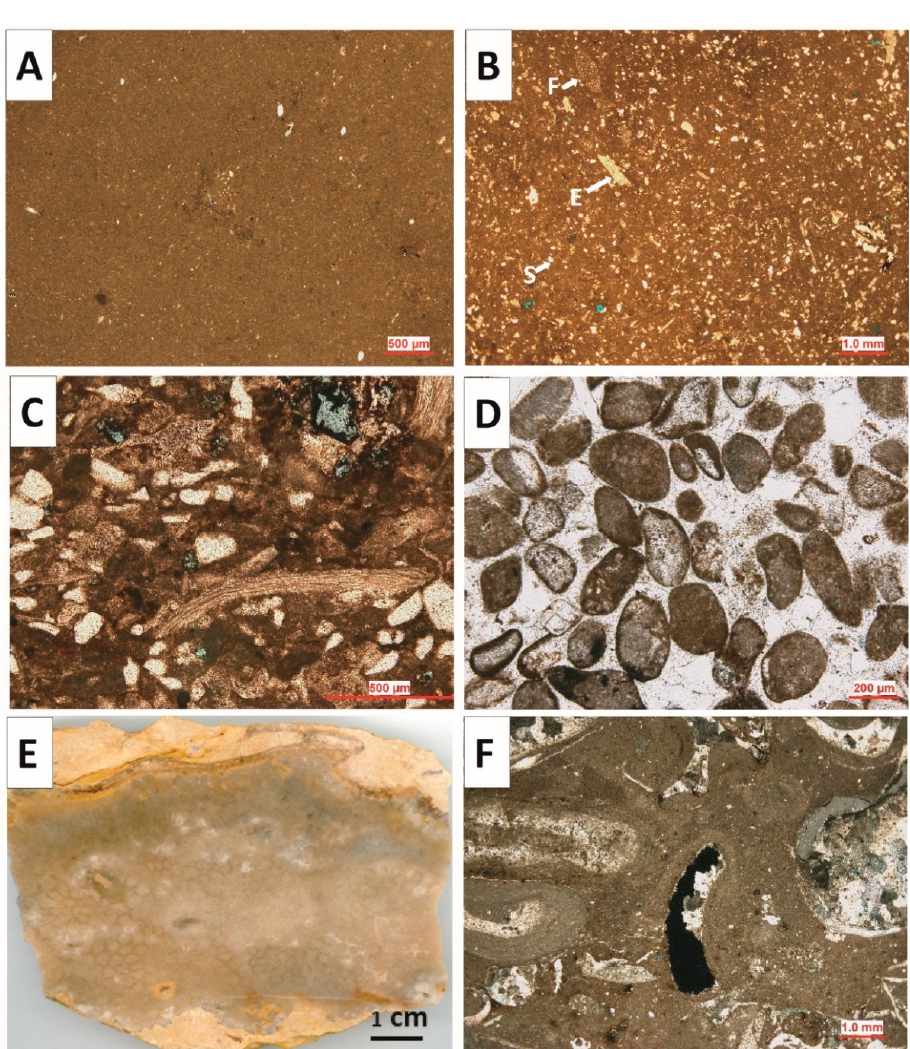
Figure 3. Lithofacies of Hanifa Formation: ( A ) Massive carbonate mudstone with scattered monaxon sponge spic- ules and agglutinated foraminifera ( Kurnubia palastineinsis ). ( B ) Wackestone facies composed of monaxon and tri- axon sponge spiculitic wackestone. Associating biocomponents are echinoderm spines ( E ), and agglutinated foraminifera ( F ), and scattered fragments of sponge spicules (S). ( C ) Packstone lithofacies dominated by skeletal grains (mainly bivalves), sub-rounded poorly-sorted quartz grains and fine peloids. ( D ) Grainstone lithofacies composed of peloids with scattered quartz grains, cortoids, and grapestones. ( E ) Polished slab of a highly cemented scleractinian coral head, which is the main reef builder in the studied succession. ( F ) Oncoidal rudstone beds as- sociating the reefal limestone. Scale bar at bottom right.